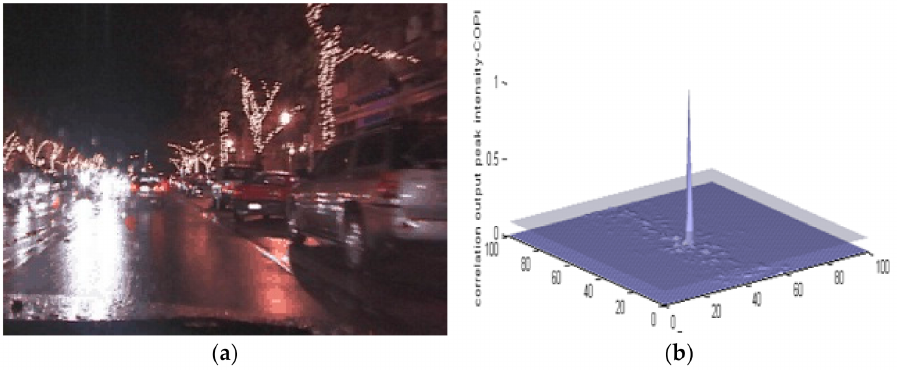
Figure 4. ( a ) Vehicle traveling at night (Data Set-3) ( b ) MACH